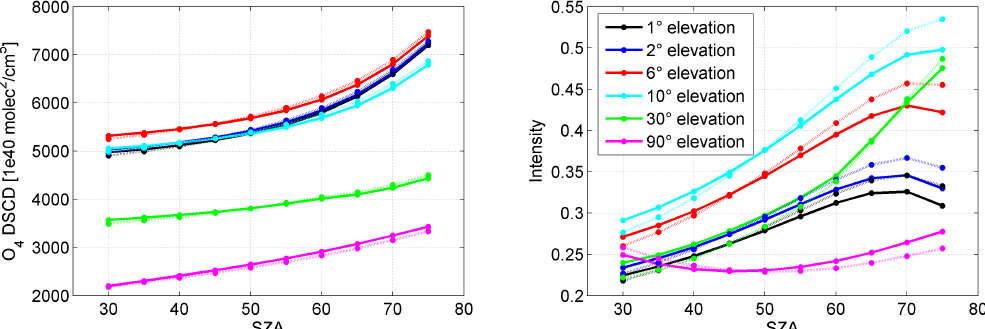
Fig. 6. Illustration of the effect of polarization on the simulation of O 4 DSCDs (left) and intensities (right). The solid lines represent the DSCDs and intensities simulated without taking polarization into account, while the dotted lines represent simulations with polarization. The simulations were performed using the DAK code (van de Haan, 1987) for a US standard atmosphere with an aerosol layer having a constant aerosol extinction of 0.1km − 1 from the surface up to 1km. The single scattering albedo of the aerosol was 0.98 and the asymmetry factor 0.73. The relative azimuth angle was 180 ◦ .